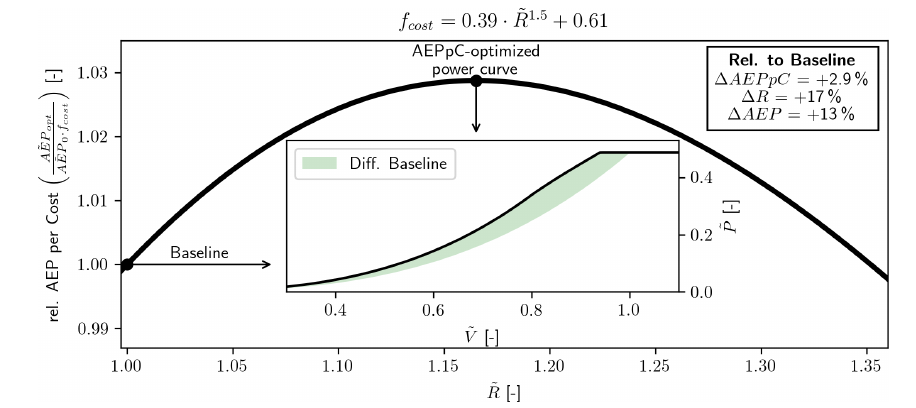
Figure 11. Relative AEP-per-cost (AEPpC) vs. relative radius increase ( ˜ R ). The insert shows the cost-optimized power curve with the shaded region showing the difference to the baseline power curve. The optimization is seen to reach a cost improvement of (cid:49) AEPpC = 2 . 9% with a radius increase of (cid:49)R = 17% as well as an AEP increase of (cid:49) AEP = 13%.